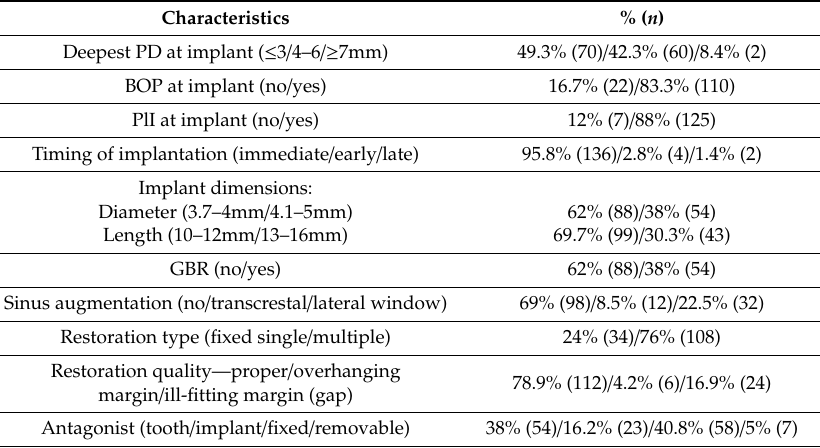
Table 3. Implants related data.